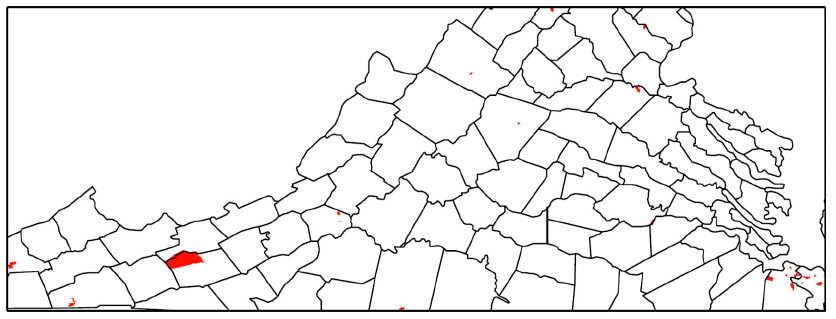
Figure 4. Census tracts with significantly elevated risk of vape shop outlets with county boundaries in Virginia, 2018.